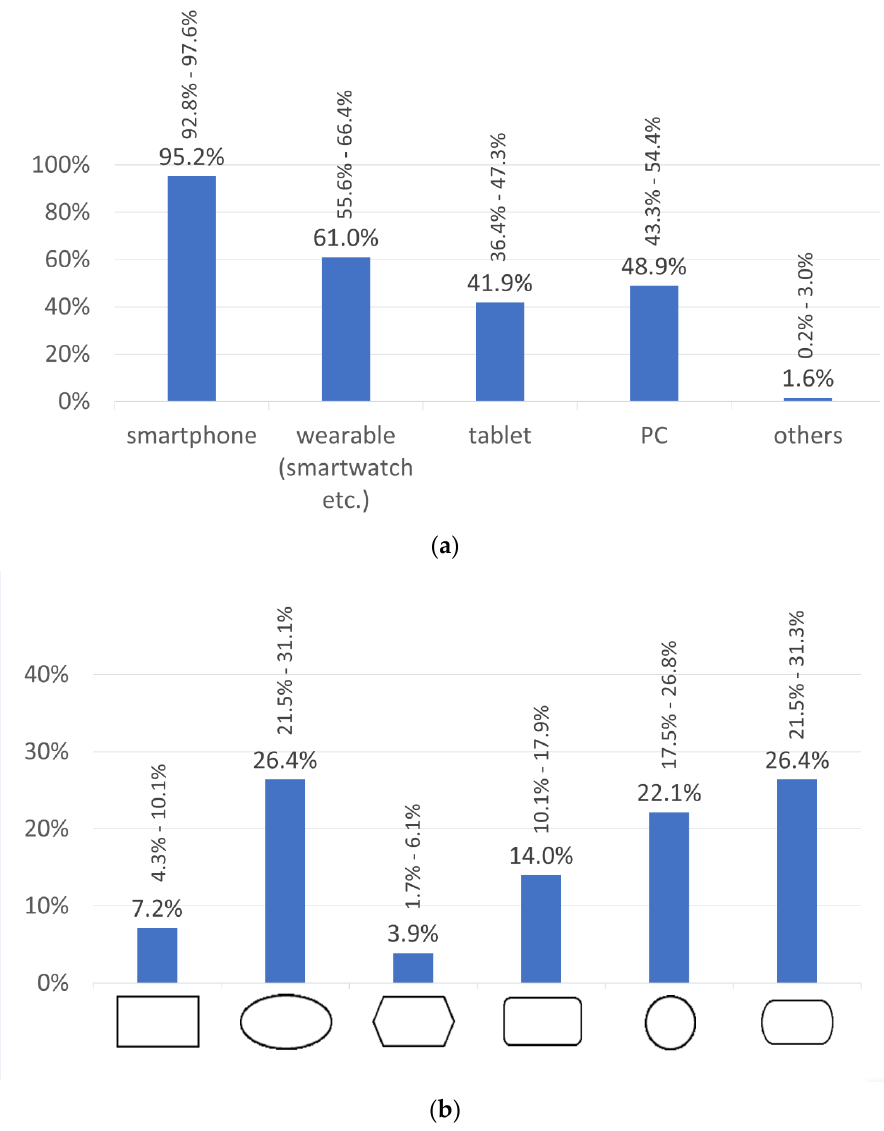
Figure 2. ( a ) Preferred terminal device for use of the ELSAH-patch. ( b ) Preferred shape of the ELSAH-patch. Values are expressed as percentages with 95%-CIs.